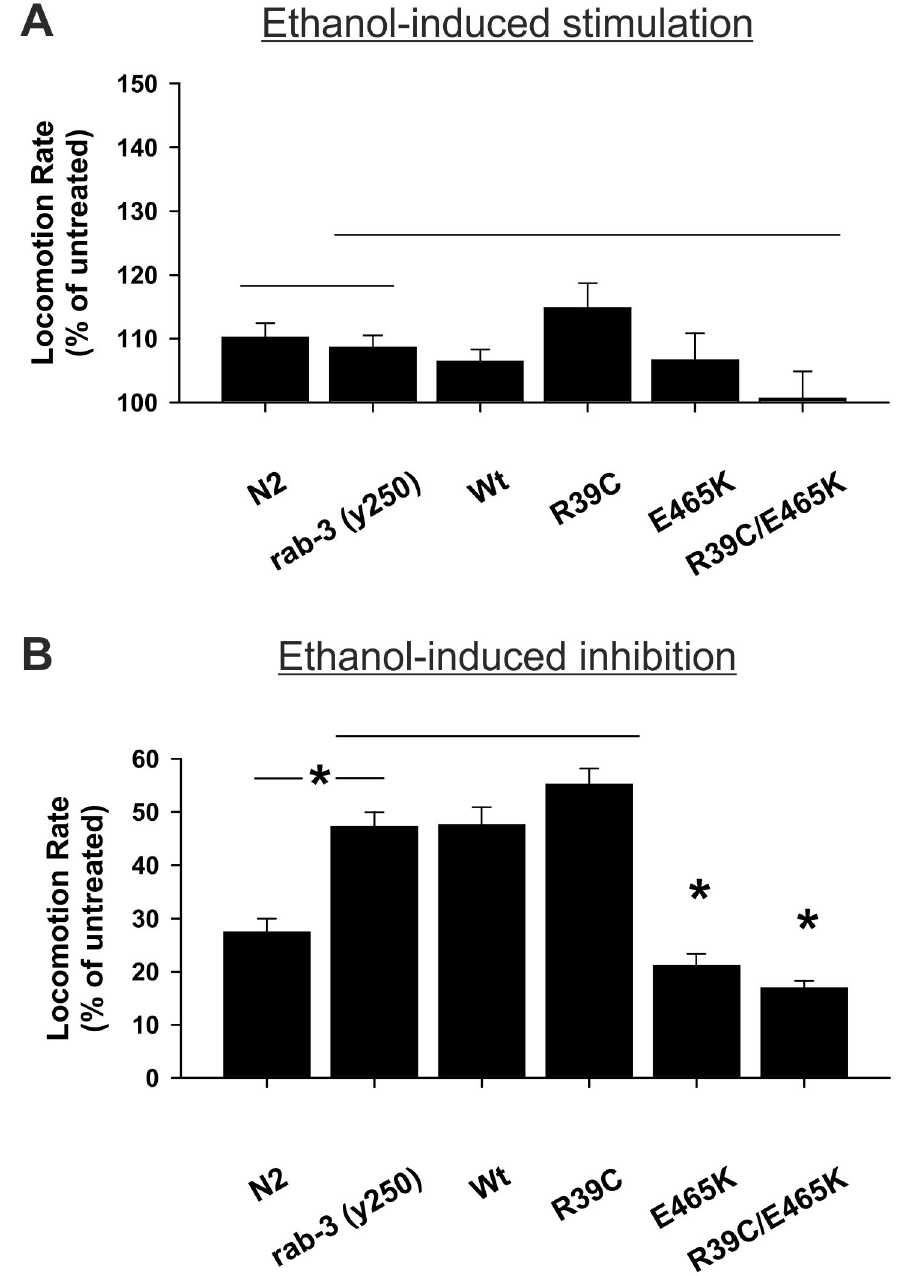
Figure 4. The E465K unc-18 point mutation suppresses the rab-3 -dependent resistance to alcohol. Loss-of-function ( lof ) rab-3 ( y250 ) worms were created to express transgenically wild-type (Wt) unc-18 or unc-18 with the indicated mutations. (A) Expression of either Wt or mutant unc-18 in a lof rab-3 genetic background did not alter acute sensitivity to external ethanol at stimulatory levels (21 mM). Significance was assessed by one-way analysis of variance; P=0.46; N = 29 (N2), 37 ( rab-3 ), 31 (Wt), 31 (R39C), 31 (E465K) and 31 (R39C/E465K). (B) In comparison to Bristol N2 controls, lof rab-3 worms had decreased acute sensitivity to external ethanol at inhibitory levels (400 mM). Expression of either unc-18 E465K or R39C/E465K, but not R39C, was dominant to rab-3 . Significance was assessed by Kruskal-Wallis one-way analysis of variance on ranks with post-hoc comparisons; *P<0.05; N = 33 (N2), 40 ( rab-3 ), 30 (Wt), 31 (R39C), 31 (E465K) and 31 (R39C/E465K).